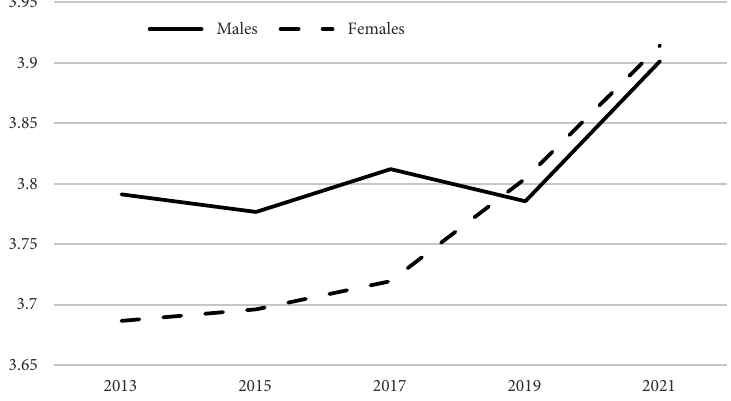
Figure 1. Average job satisfaction for males and females from 2013 to 2021 (source: own